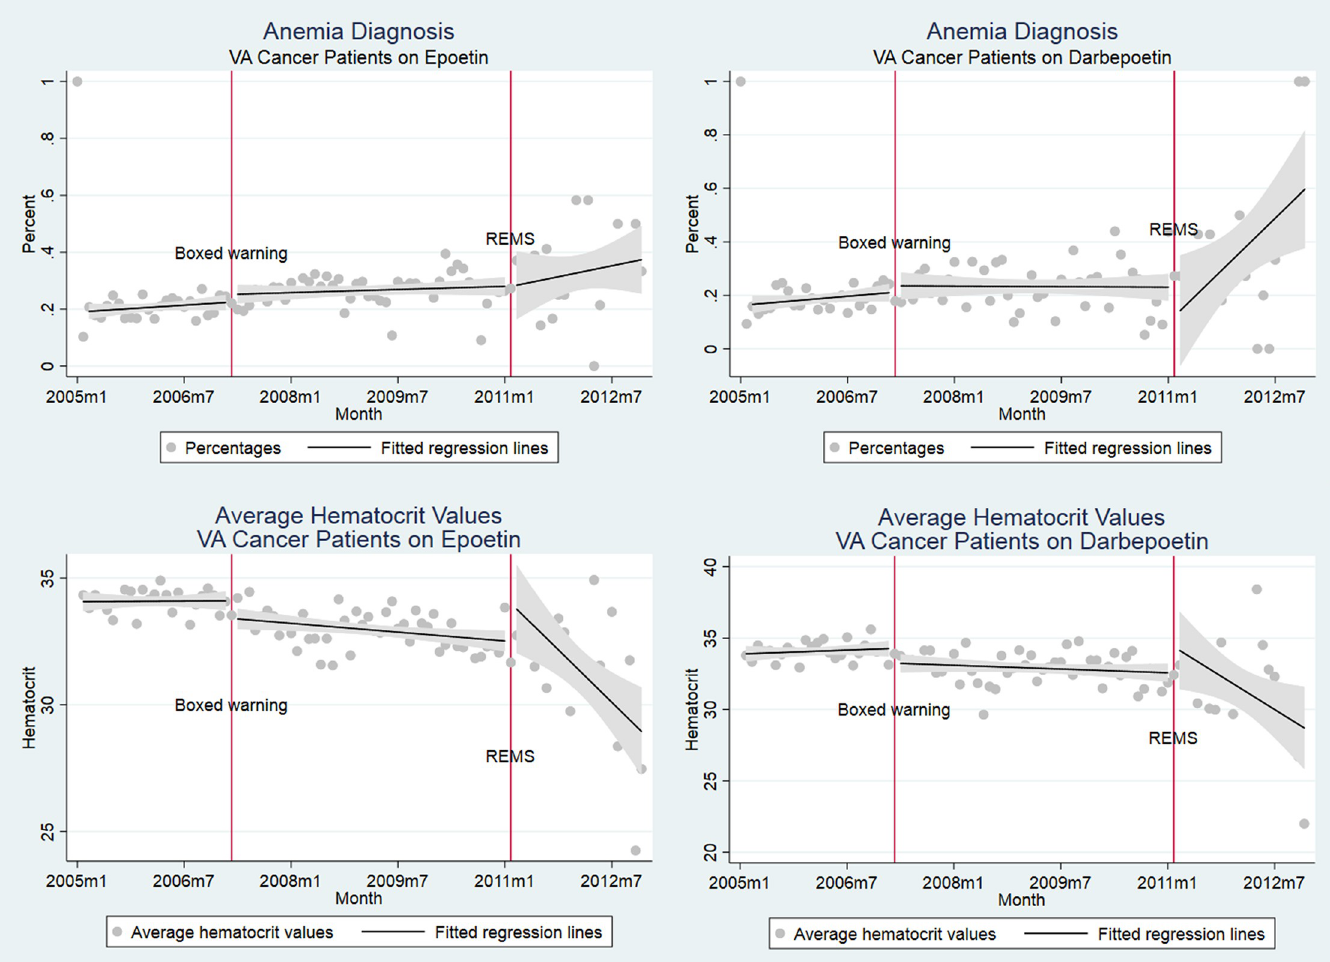
Fig 3. Percent of VA cancer patients with anemia diagnosis (a) epoetin, (b) darbepoetin, and average hematocrit levels of VA cancer patients (a) epoetin, (b)